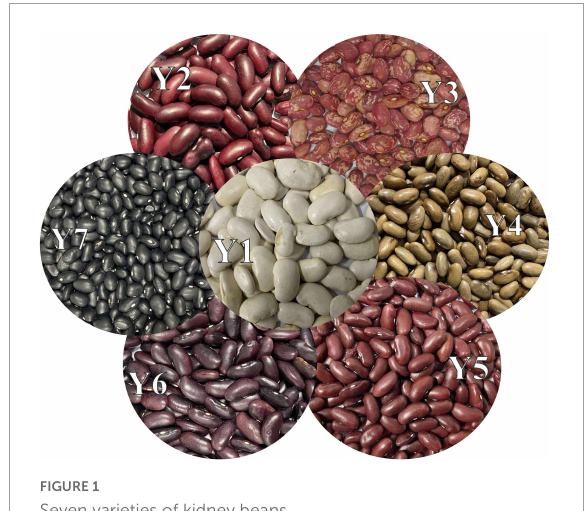
FIGURE1 Seven varieties of kidney